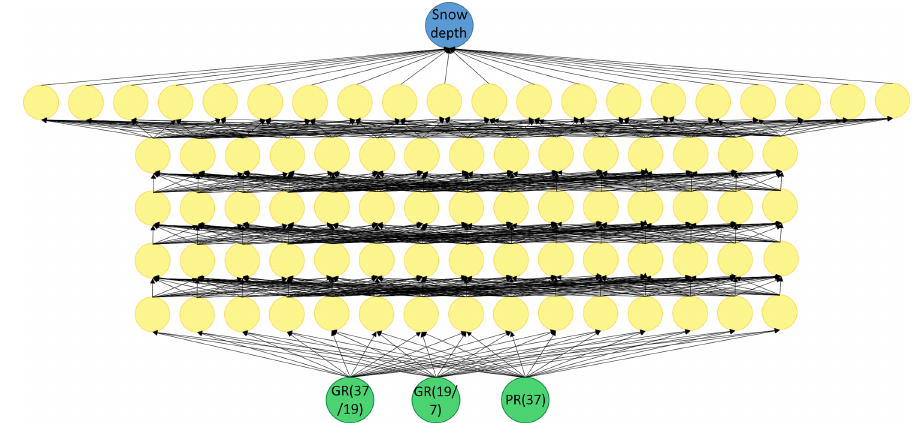
Figure 1. Architecture of the AMSR2-only neural network: the 37 / 19 gradient ratio, the 19 / 7 gradient ratio and the polarization ratio at 37GHz are used as input (green circles). They are transformed by five fully connected hidden layers with 15 or 20 neurons each (yellow circles) to finally produce snow depth as output (blue circle). Each neuron (circle) has a bias and each connection (arrow) is associated with a different